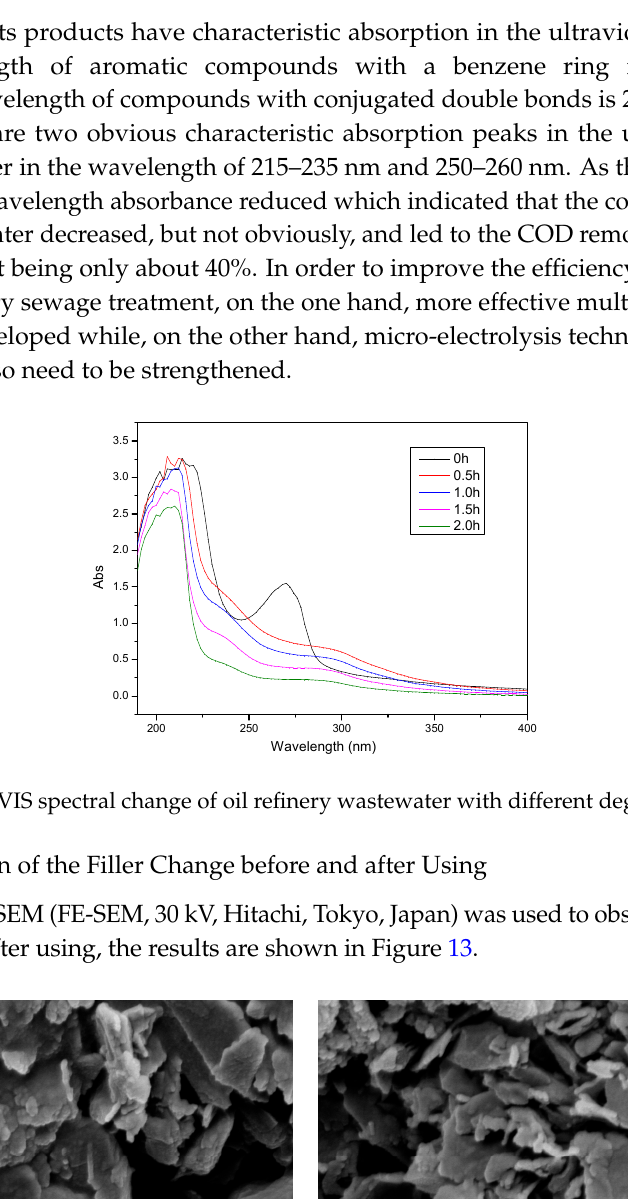
Figure 11. GC–MS chromatograms on dichloromethane extract from ( a ) influent and ( b ) effluent of the micro-electrolysis reactor. Table 4. Main component distribution of the raw oil refinery wastewater. No. Retention Time (min) Compounds Molecular Formula Proposed Structures